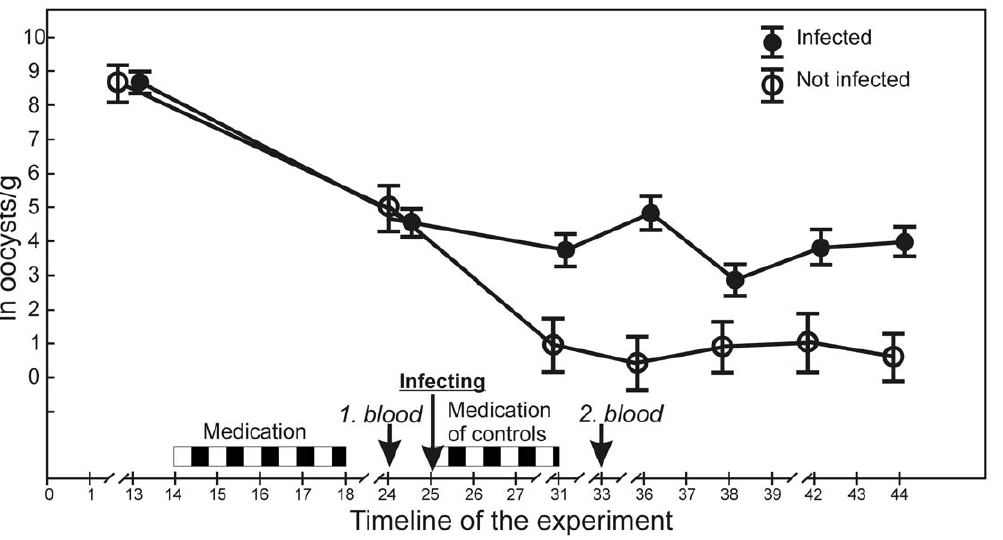
Figure 1. Timeline of the experiment and dynamic of the infection. Day 1=4 January. Effect of treatment: F 1,54 =13.2, P=0.006; Effect of time: F 6,324 =52.9, P , 0.00001; Effect of time*treatment F 6,324 =36.3, P , 0.00001. Average infection intensities did not differ between infected and not infected birds before infecting (P=0.6–1), while after infecting, infected group had significantly higher oocyst shedding in any date of measurement (P=0.03–0.0001).